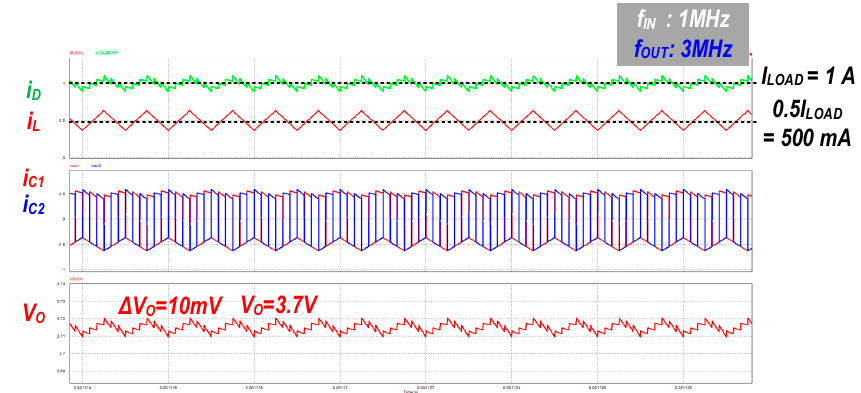
Figure 22. Simulated waveforms of the MBKETM with f IN = 1 MHz and f OUT = 3 MHz.